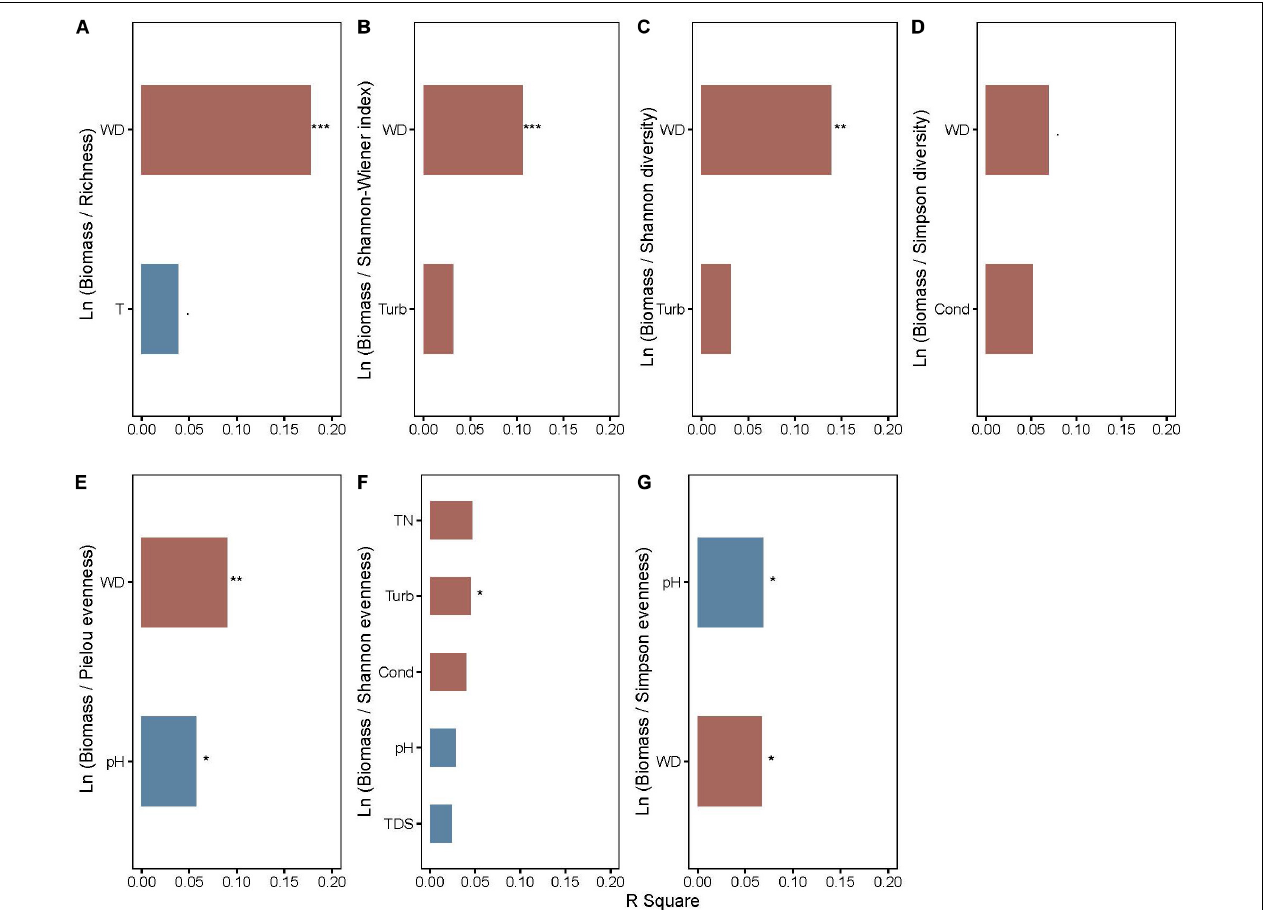
FIGURE 4 | The rank of explanation power of environmental factors on (A) ln (biomass/richness), (B) ln (biomass/Shannon–Wiener index), (C) ln (biomass/Shannon diversity), (D) ln (biomass/Simpson diversity), (E) ln (biomass/Pielou evenness), (F) ln (biomass/Shannon evenness), and (G) ln (biomass/Simpson evenness) of aquatic macrophytes. WD, water depth. Red and blue bars represent positive and negative effects, respectively. Significance levels are indicated by asterisks: *** P < 0.001, ** P < 0.01, * P < 0.05, P < 0.1.